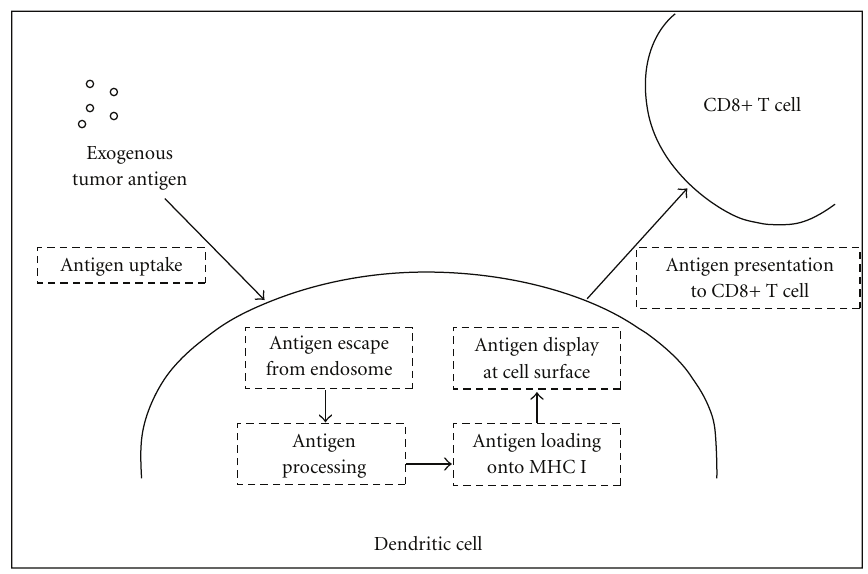
Figure 1: General mechanism of tumor antigen cross-priming to CD8+ T cells. In the process of cross-priming, exogenous tumor antigen (which may be released from tumor cells via apoptosis, necrosis, or immune-mediated damage) is endocystosed by the DC. Antigen then escapes from the endosome and is processed and loaded onto MHC class I alongside cytosolic antigens. Peptide-loaded MHC class I molecules are ultimately transported to the cell surface, where they may encounter and activate CD8+ T cells through interactions with the T cell receptor